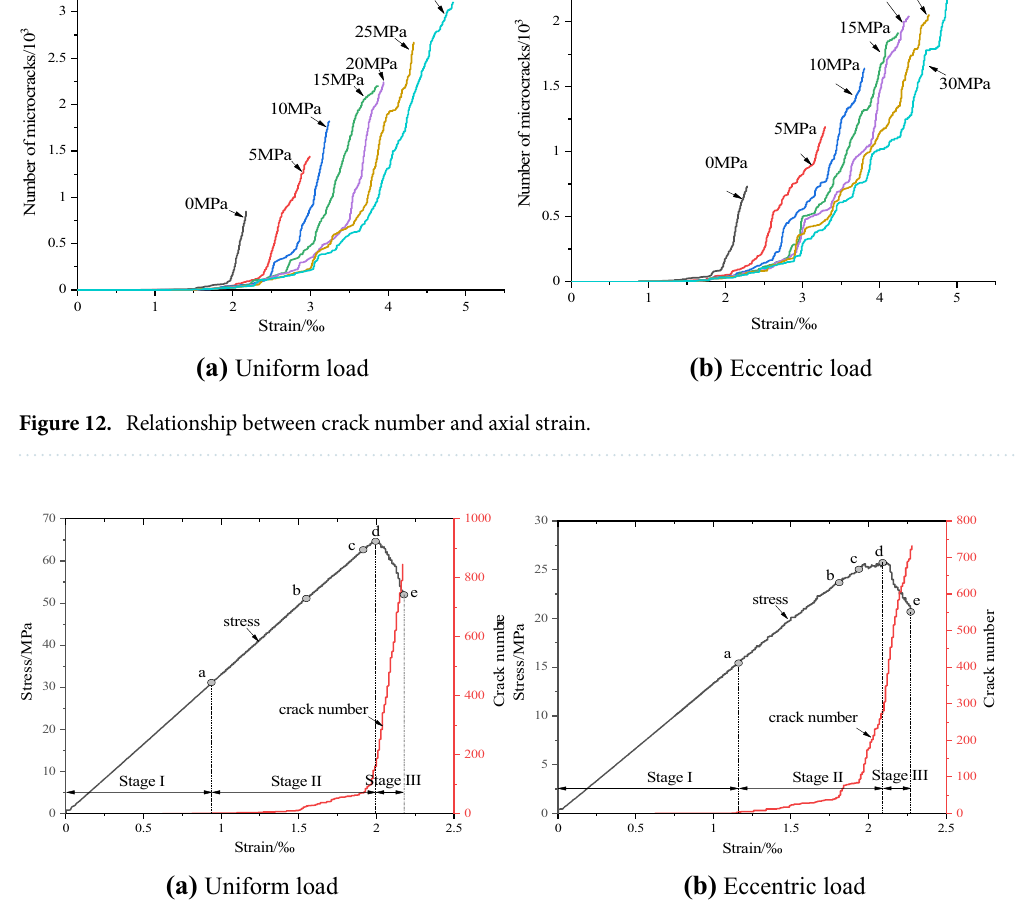
Figure 13. Relationship between crack number and stress–strain evolution under uniaxial compression.